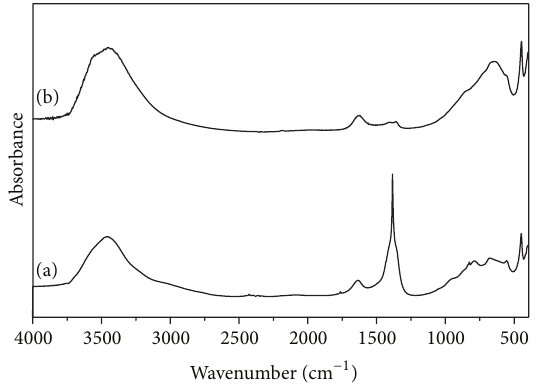
Figure 2: FTIR spectra for (a) LDH and (b) Pd/LDH composite. Table 1: CHN elemental analysis of LDH and Pd/LDH composite. Sample C (%)